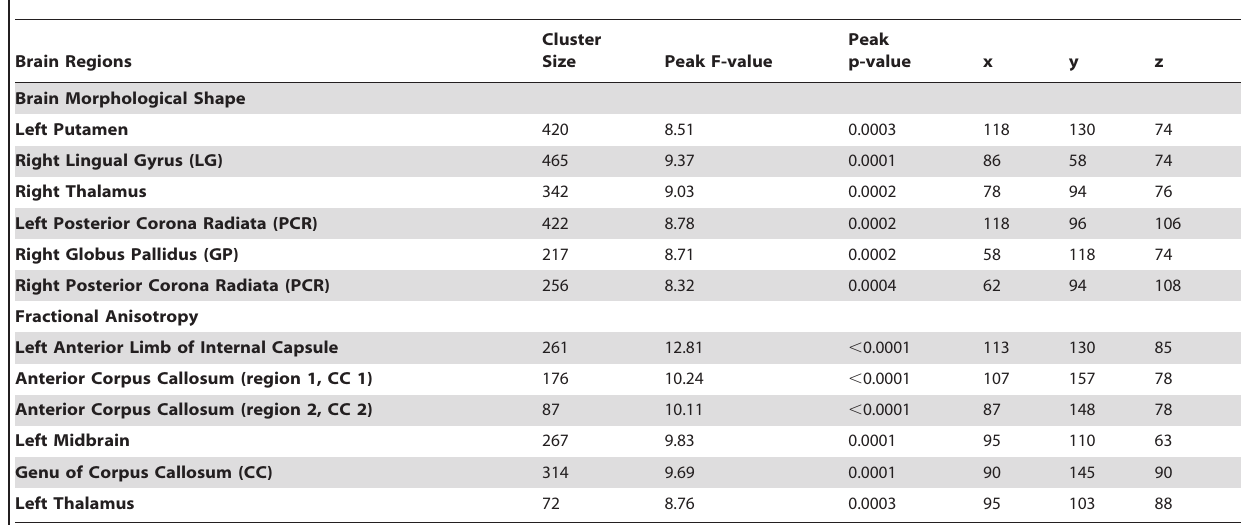
Table 3. Population group comparisons in brain morphological shape and fractional anisotropy.